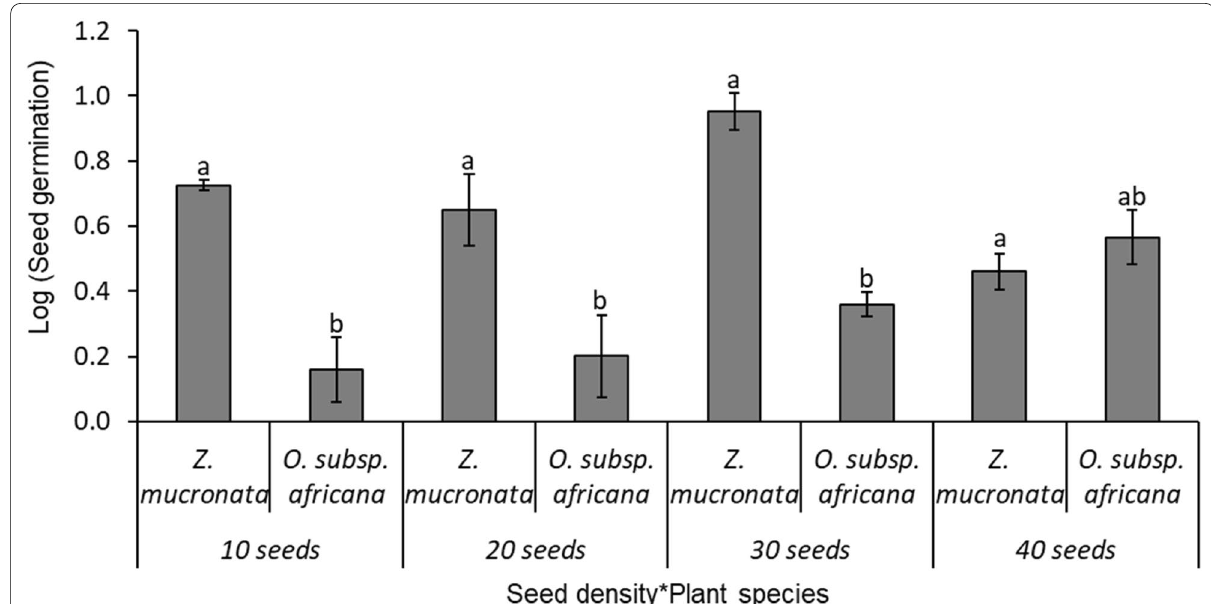
Fig. 4 Mean seed germination for different plant species in competition level 1 between two tree/shrub species: Z. mucronata and O. subsp. africana. The error bars represent the standard error of sample mean, and different letters above standard error bar denote significant differences between seed density